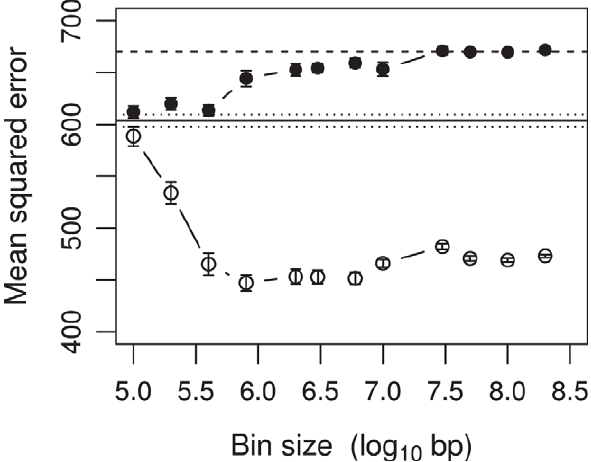
Figure 6. Mean squared error for the carcass trait of beef cattle plotted against the bin size. The filled circles indicate the MSE under the infinitesimal model while the open circles indicate the MSE under the adaptive infinitesimal model. The dashed horizontal line represents the phenotypic variance of the simulated trait (670.36). The solid horizontal line along with the two dotted lines represents the MSE and the standard deviation of the MSE in the situation where the bin size was one (one marker per bin). The sample size was n ~ 836 and the number of SNP markers was p ~ 40809 . The bin size was defined as log 10 bp. For example, the largest bin size log 10 bp ~ 8 : 3 means that the bin size contains 2 | 10 8 base pairs.